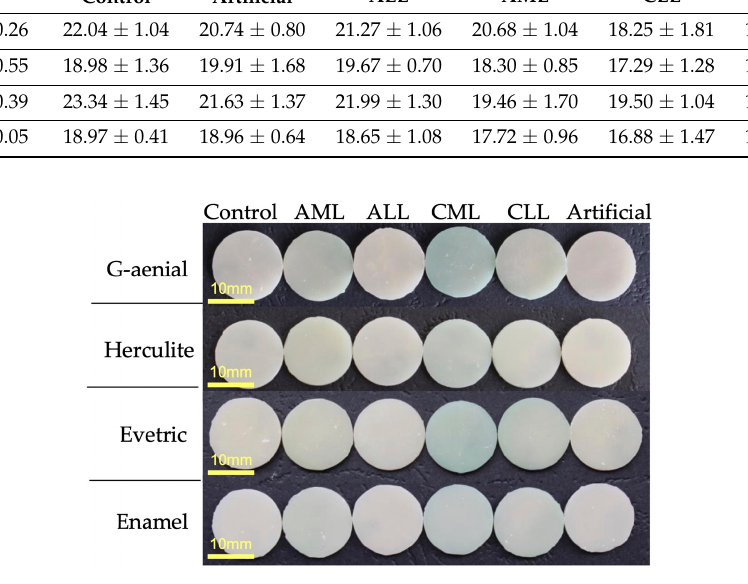
Table 3. Color changes in the dental composites’ using VITA EasyShade.